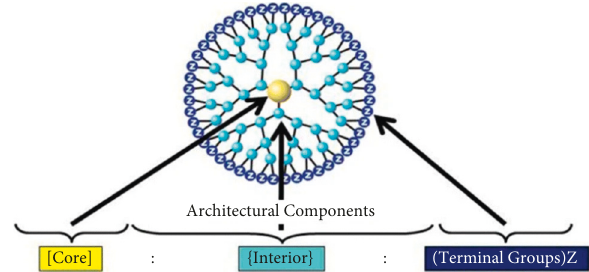
Figure 1: Dendrimer architecture.